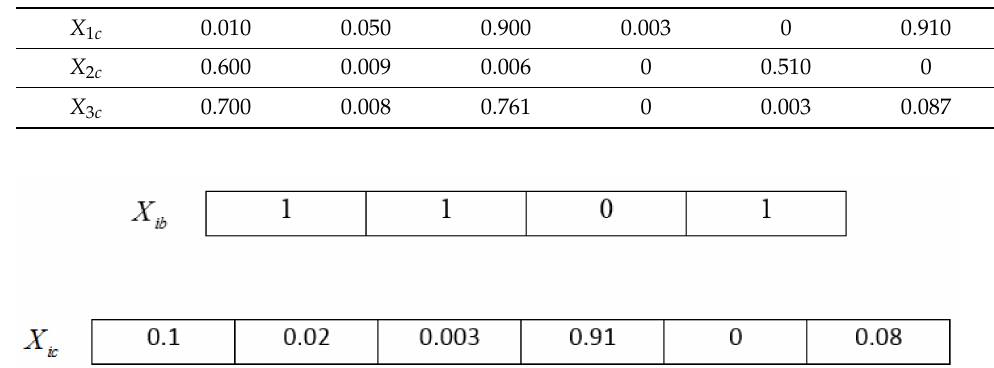
Figure 3. An example of a candidate solution, which consists of binary and continuous